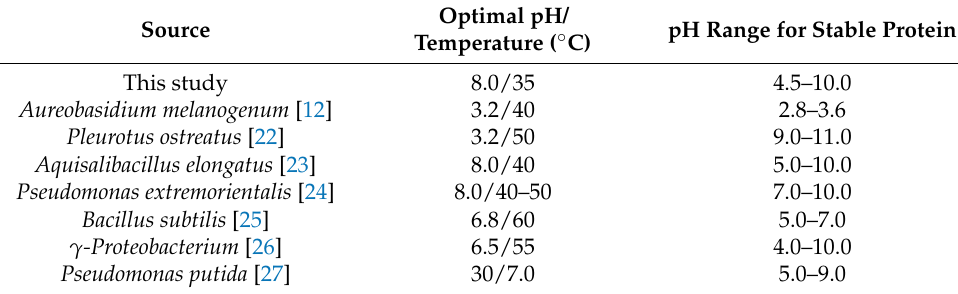
Table 1. Comparison of properties between L01 and reported laccases.